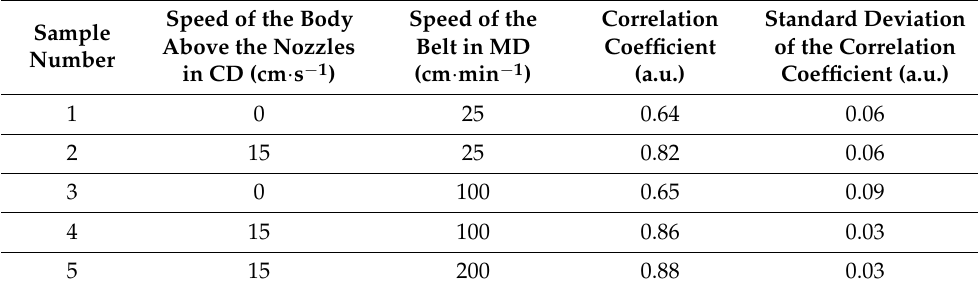
Table 1. Results of the image analysis of layers deposited using different process parameters.